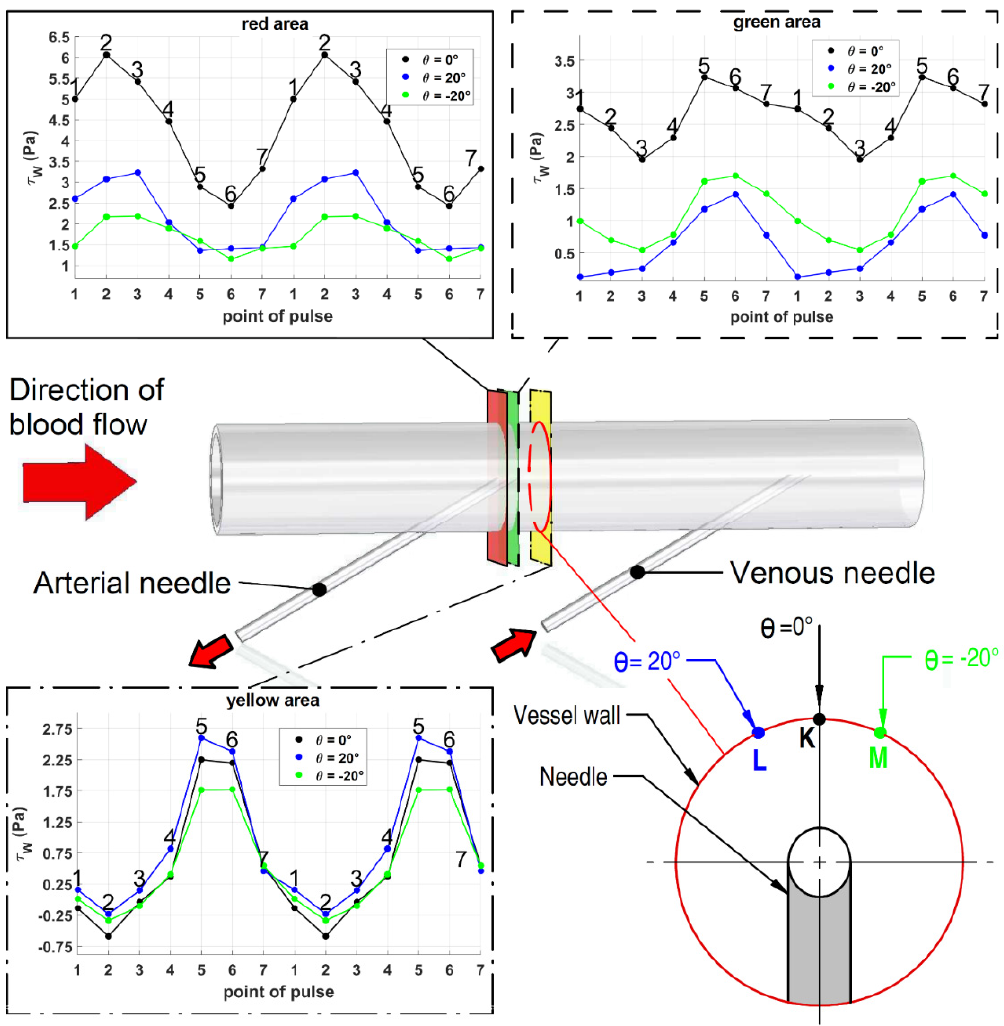
Figure 6. Wall shear stress for defined points K, L and M for all pulse points of the peristaltic pump in the selected measured areas. The bottom right part of the figure shows the monitored points locations on the inner surface of the vessel in a cross-sectional view. Three points (“K”, “L” and “M”) were chosen for three selected measured areas (red, green and yellow). At these points, WSS was monitored during pulse of the peristaltic pump. Red area ( upper left graph): a clear oscillation character of WSS can be seen for all monitored points. Directly above the needle (black line) the WSS values for all pulse points are higher than for the other two observed angles. This is caused by the drawn blood flow of the needle affecting the flow in the artery. A maximum value of 6 Pa was reached at pulse point 2 for the angle θ = 0 ◦ . Green area ( upper right graph): the values of WSS for the angle θ = 0 ◦ are significantly higher than for the other two angles. For all measured areas, a phase shift of the maximum of the wall tangential stress compared to the red area can be observed. This phase shift is caused by a drop in volumetric flow rate due to a significant amount of blood being drawn from the vascular access. At pulse points 5 and 6, no blood is being drawn and a portion of the drawn blood volume is returned to the artery through the arterial needle. The maximum WSS of 3.25 Pa was observed for the angle θ = 0 ◦ . Yellow area ( bottom graph): the curve of WSS is similar for all measured points. A clear drop to negative values of WSS is observed at pulse point 2 for all